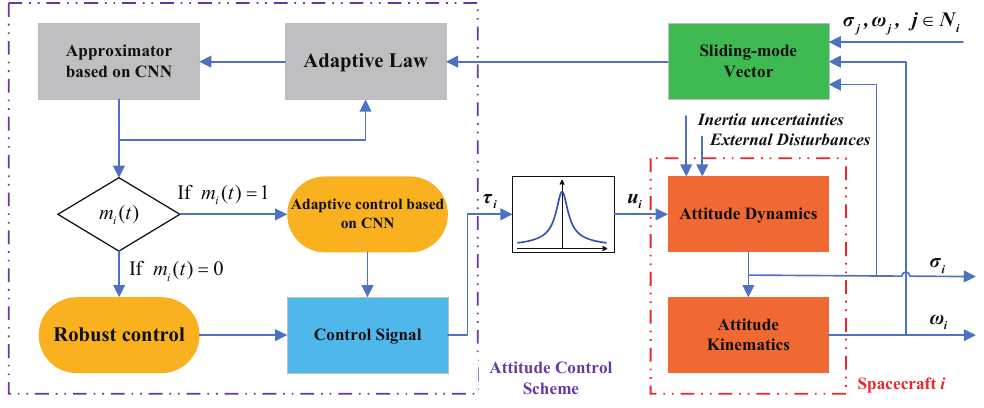
Figure 1. Block diagram of the proposed attitude